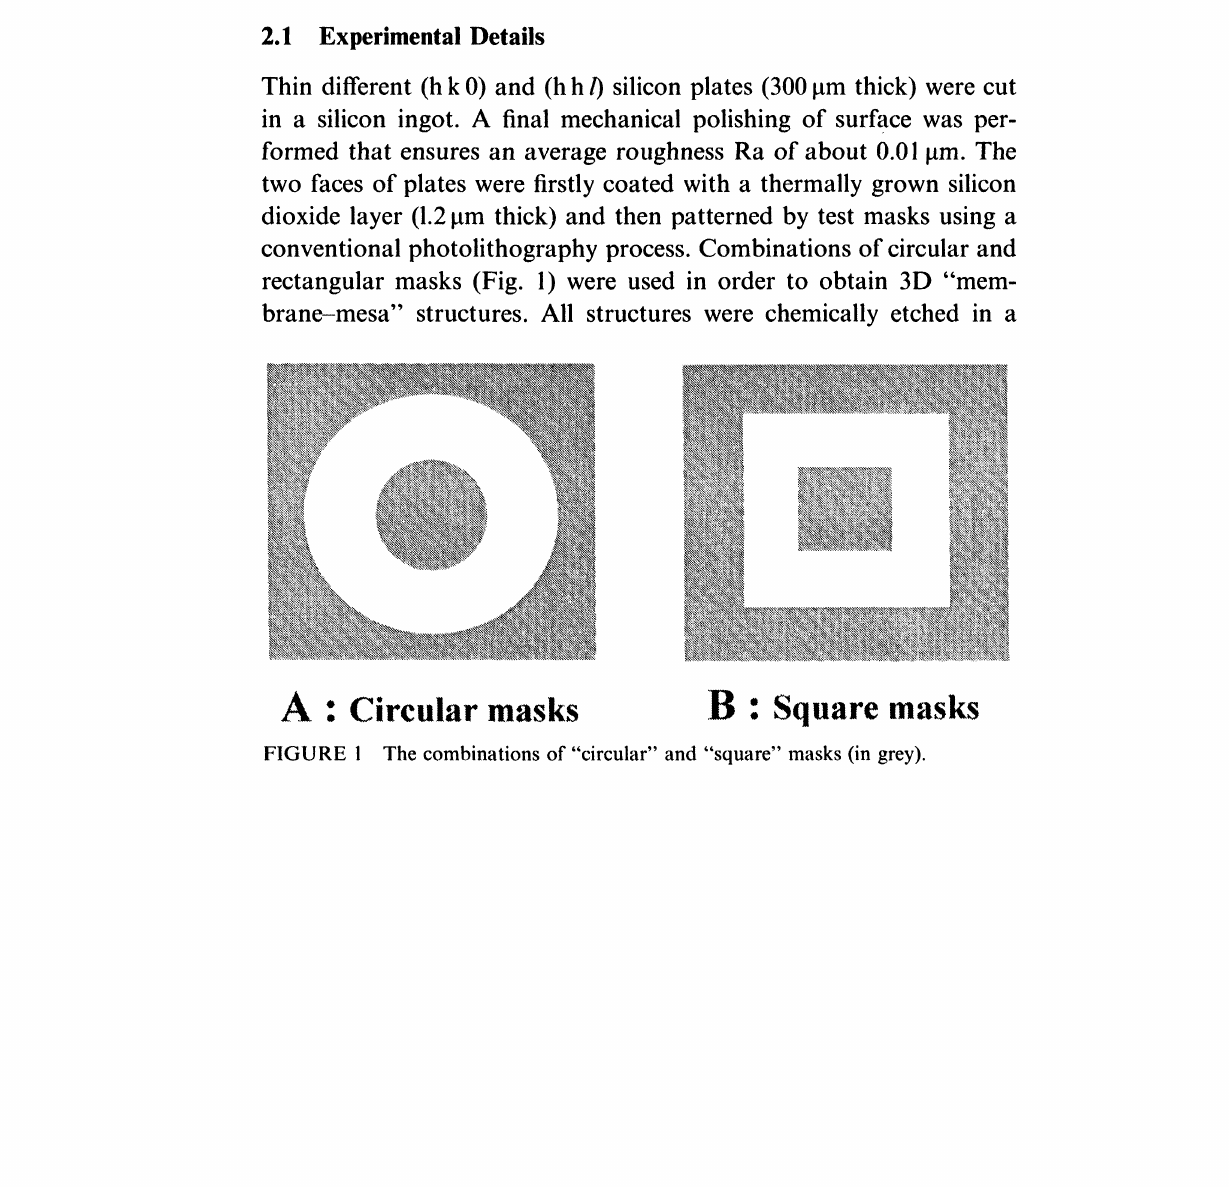
FIGURE The combinations of "circular" and "square" masks (in